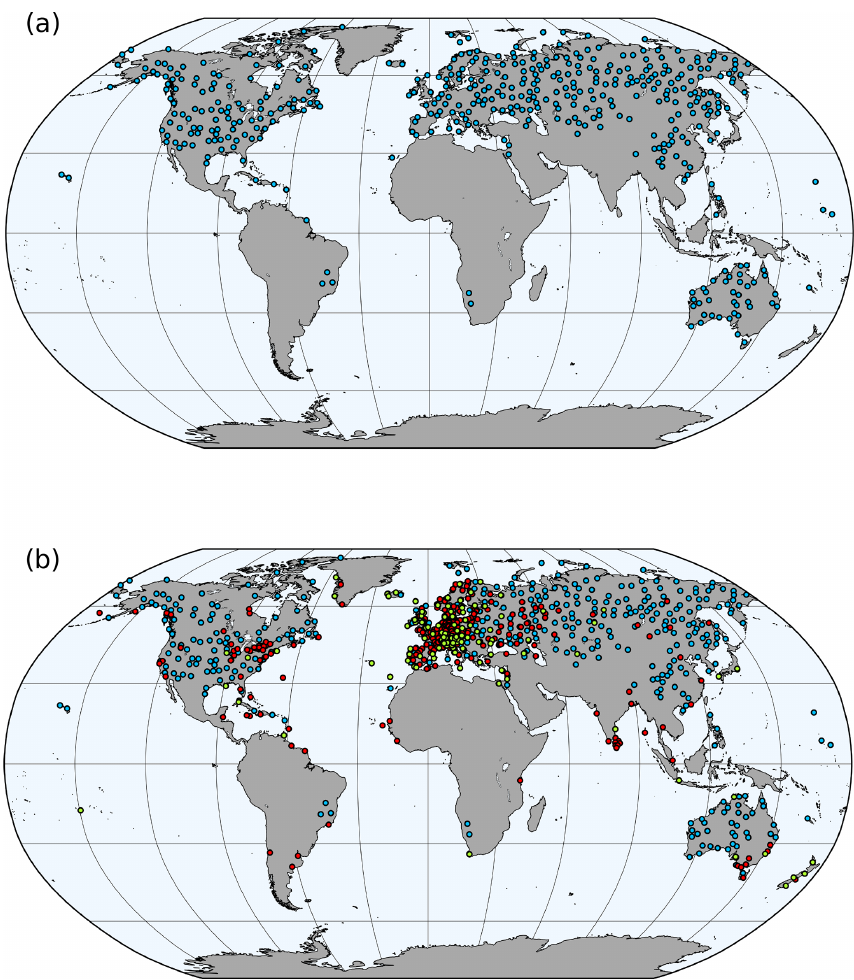
Figure 1. The location of precipitation observations (a) used in the exp_R, exp_W, exp_R_2L, and exp_W_2L experiments. The location of instrumental precipitation (blue), temperature (red), and sea-level pressure (green) observations (b) assimilated in the exp_TPR and exp_TPW